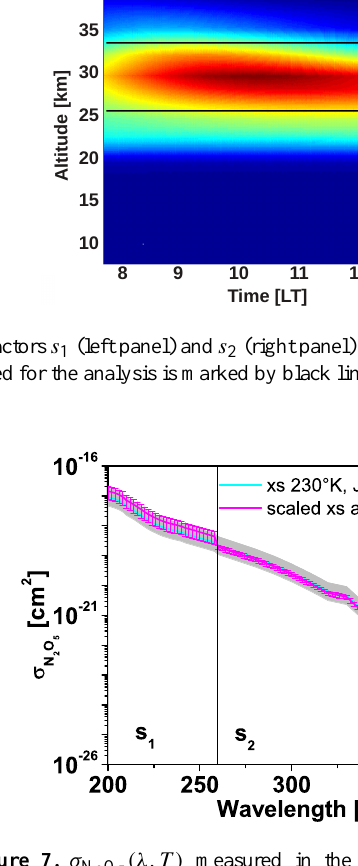
Fig. 5. Sensitivity of the NO 2 concentration in our model to the scaling factors cross-section of N 2 O 5 . Units are given in 10 7 molec / cm 3 . The altitude region used for the analysis is marked by black lines.